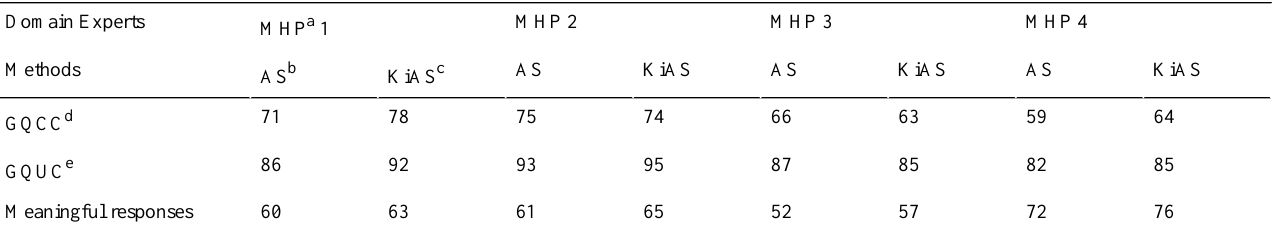
Table 4. Performance of methods on intrinsic evaluation from 4 mental health professionals gathered after counting the number of good questions with clear context, good questions with unclear context, and meaningful responses in 50 (2 methods) summaries generated.